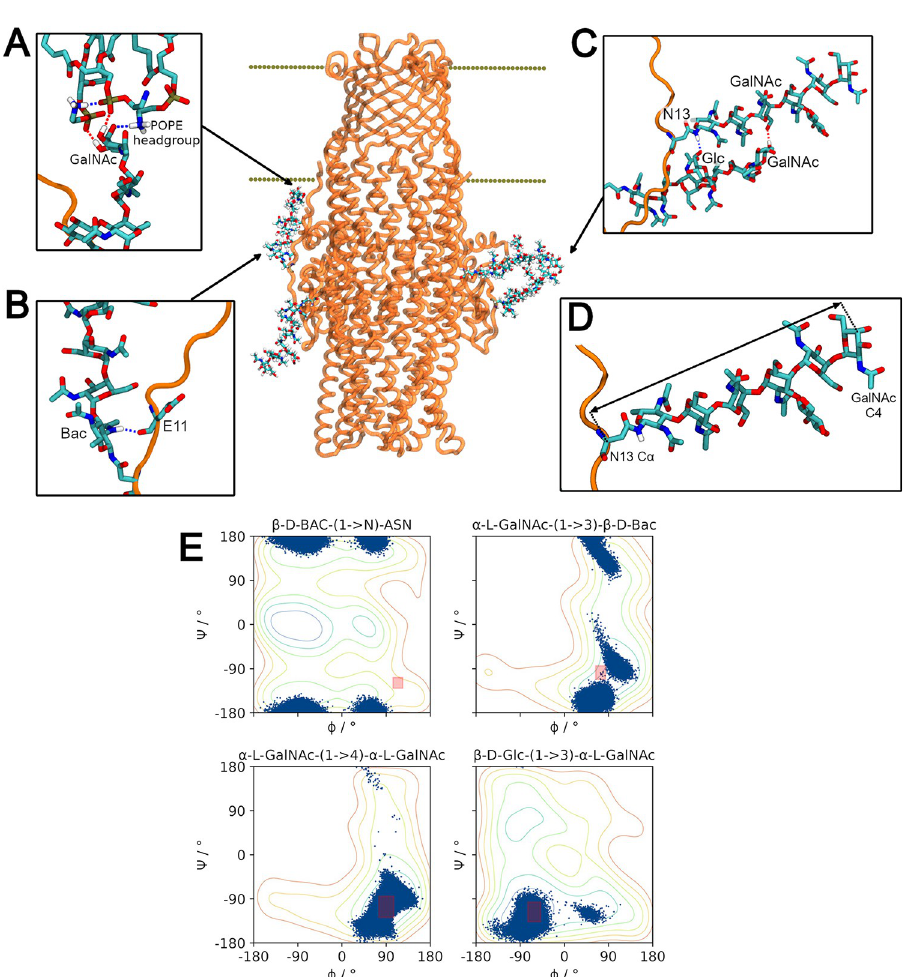
Fig 4. Glycan dynamics and interactions. (A) Terminal GalNAc moiety hydrogen bonds to the POPE headgroups in the inner leaflet of the membrane. (B) Bacillossamine moiety hydrogen bonds to the backbone of E11 in the unstructured N-terminus region of CmeC. (C) Glycans in the same protomer are observed to hydrogen bond to one another. (D) Vector defining the end-to-end length of the heptasaccharide and the direction in which the glycan is oriented. Defined between the C α of the asparagine residue and the C4 position of the terminal GalNAc moiety. (E) Scatter plot of the C and F torsion angles for each unique glycosidic linkage in the heptasaccharide, plotted in blue atop the free energy contour plots generated via metadynamics simulations by Pedebos et al (Reprinted (adapted) with permission from Ref. 60. Copyright 2015 Oxford University Press). The mean value ± the standard deviation observed for each linkage in Ref. 60 are plotted as pink rectangles on the contour plots. The glycans in our simulations show considerable exploration of the energy